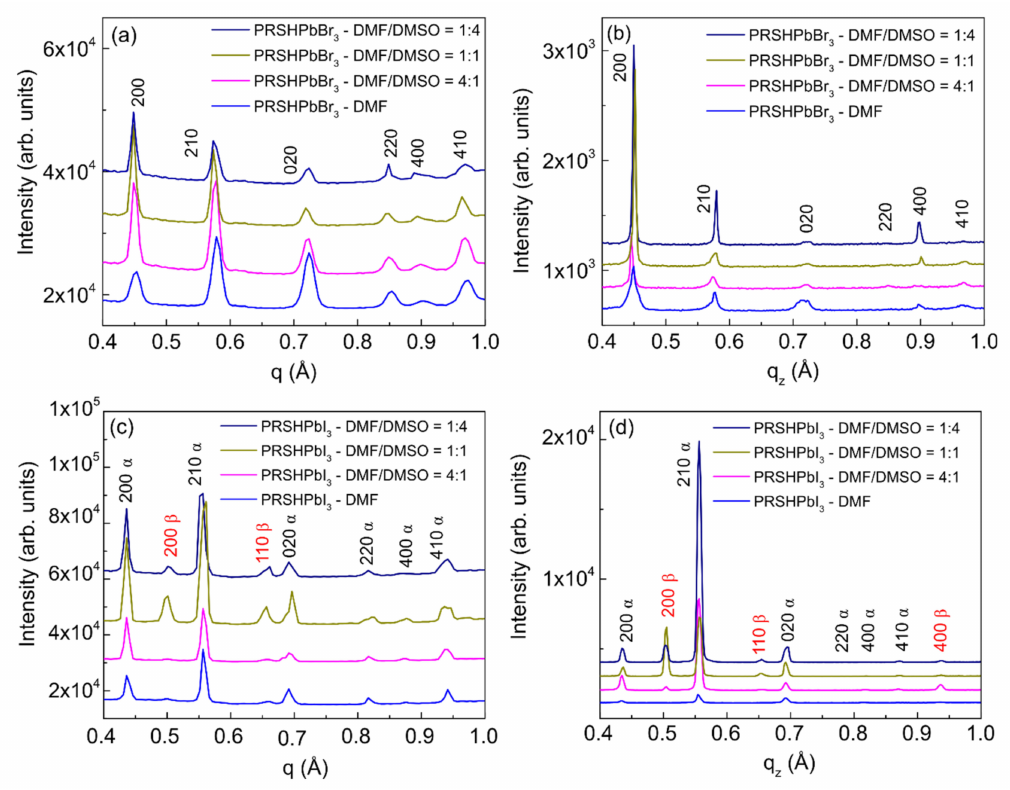
Figure 7. AZII profiles from 2D-GIXD images ( a , c ) and specular XRD scans ( b , d ) of the (PRSH)PbBr 3 and (PRSH)PbI 3 films prepared with different DMF/DMSO volume